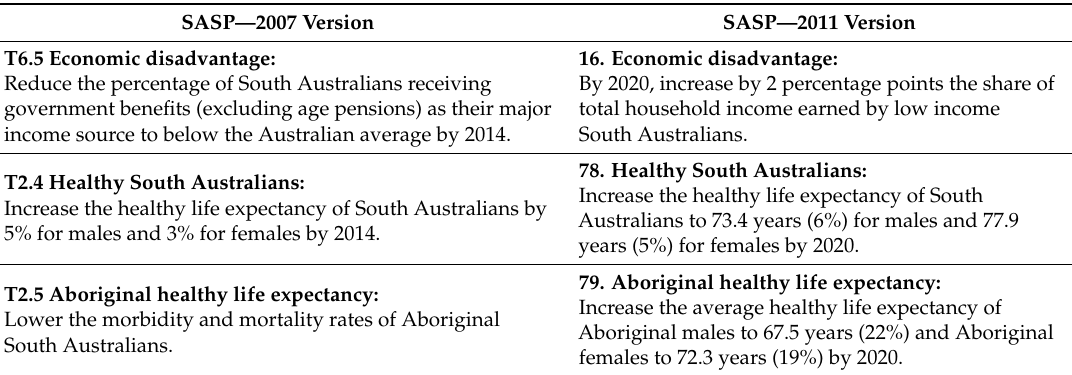
Table 3. Examples of equity-focused targets in the 2007 and 2011 versions of South Australia’s Strategic Plan